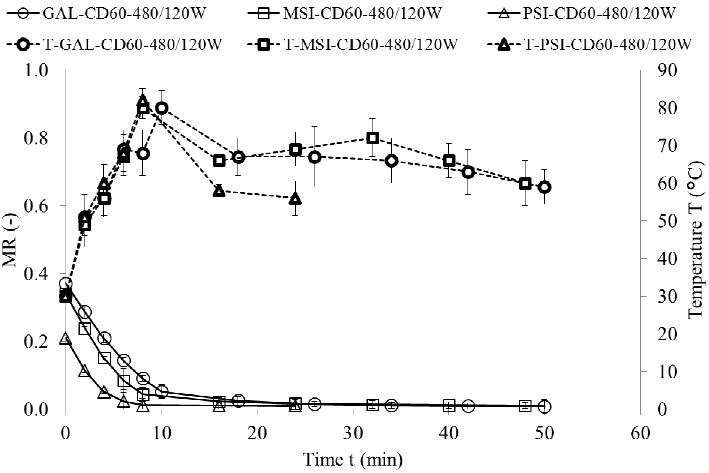
Figure 3. Drying kinetics of jujube fruits during pre‐drying by CD (60 °C) and finished by VMD (480/120W).